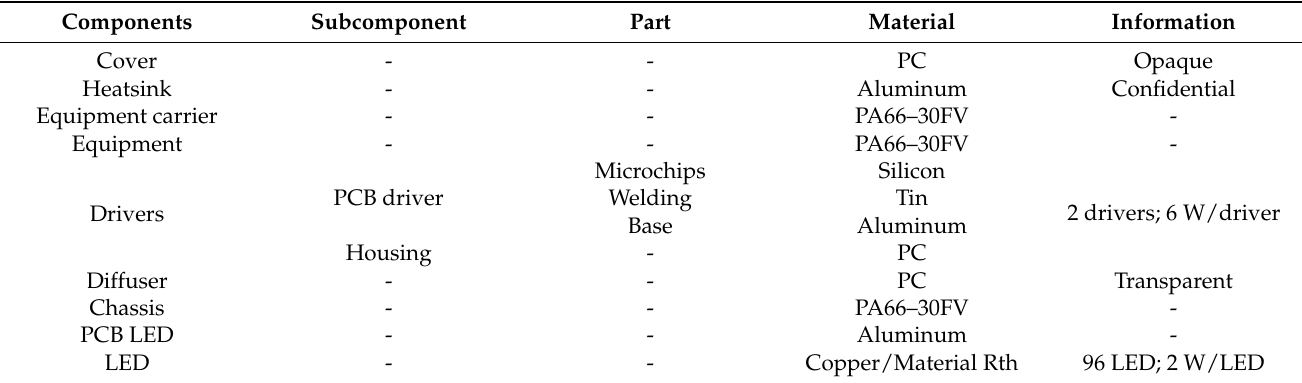
Table 1. Components, materials and powers. Source: ATP lighting S.A.